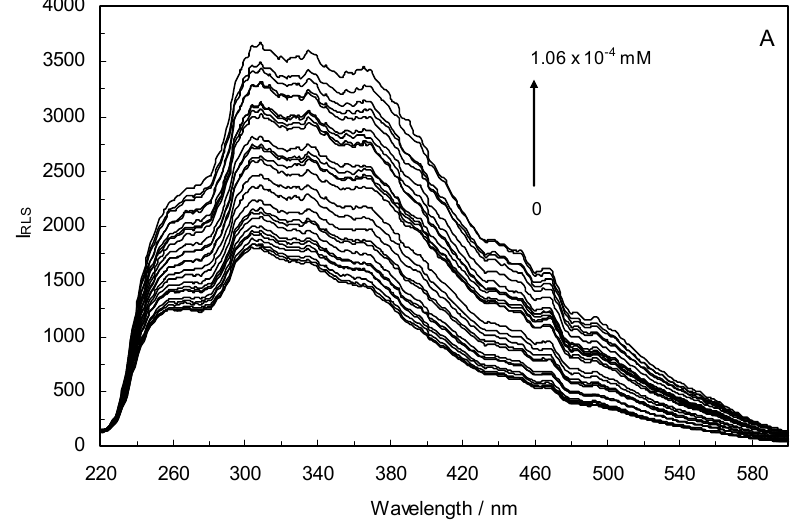
Figure 7. ( A ) The RLS spectra of hTf at varying concentrations of ROP. [hTf] = 3.8 × 10 − 3 mM; ( B ) The RLS spectra of hTf at different concentrations of ASA. intensity of hTf at various [hTf] = 3.8 × 10 − 3 mM, pH 7.4; ( C ) A plot of the ∆ I RLS concentrations of ROP in the absence and presence of ASA. [hTf] = 3.8 × 10 − 3 mM, and [ASA] = 4.62 × 10 − 3 mM for the ternary system. ( ○ ) binary system, ( ● ) ternary system; intensity of hTf at several concentrations of ASA in the absence and ( D ) A plot of the ∆ I RLS presence of ROP. [hTf] = 3.8 × 10 − 3 mM, and [ROP] = 1.33 × 10 − 5 mM for the ternary system. ( ∆ ) binary system, ( ▲ ) ternary system. All experiments were performed under identical conditions, T = 298 K, pH =